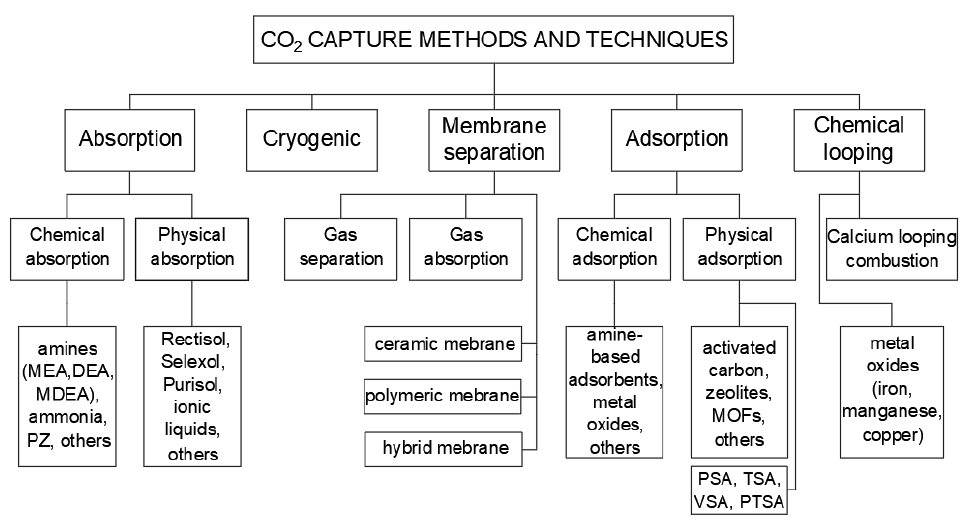
Figure 1. Methods and techniques of CO 2 capture.